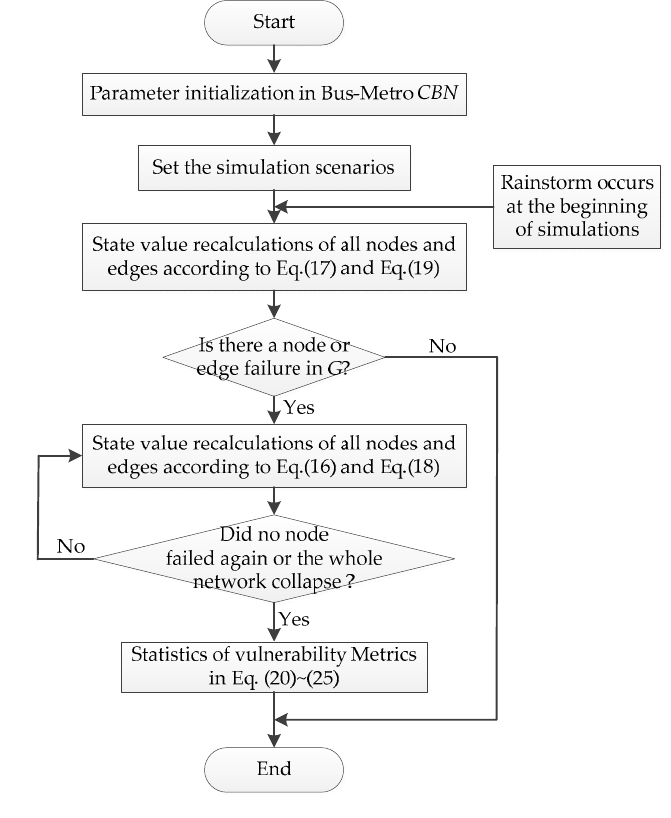
Figure 7. The simulation process. Table 5. Changes in feature indices of cascading failure in the Bus–Metro CBN .